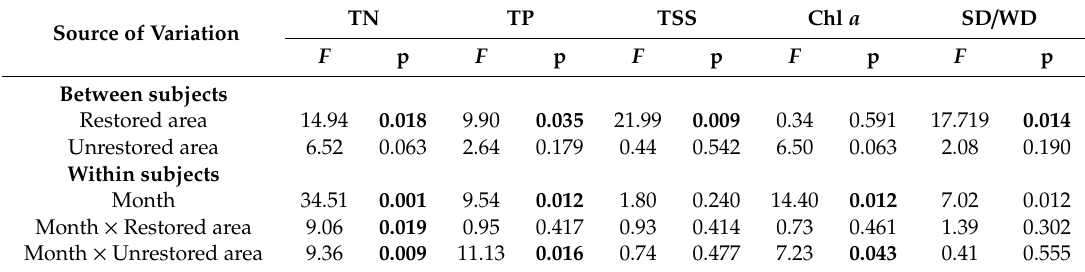
Table 2. Summary of repeated-measure ANOVA results on e ff ects of di ff erent month and lake areas (restored and unrestored areas) on the concentrations from three sites in each water quality monitoring of SD / WD (Secchi depth / water depth ratio), total phosphorus (TP), total nitrogen (TN − ), total suspended solids (TSS) and chlorophyll a (Chl a ) in restored lake areas (Wuli-E and Qin-E) and the unrestored areas (Wuli-C and Qin-C) of Lake Wuli and Lake Qinhu.